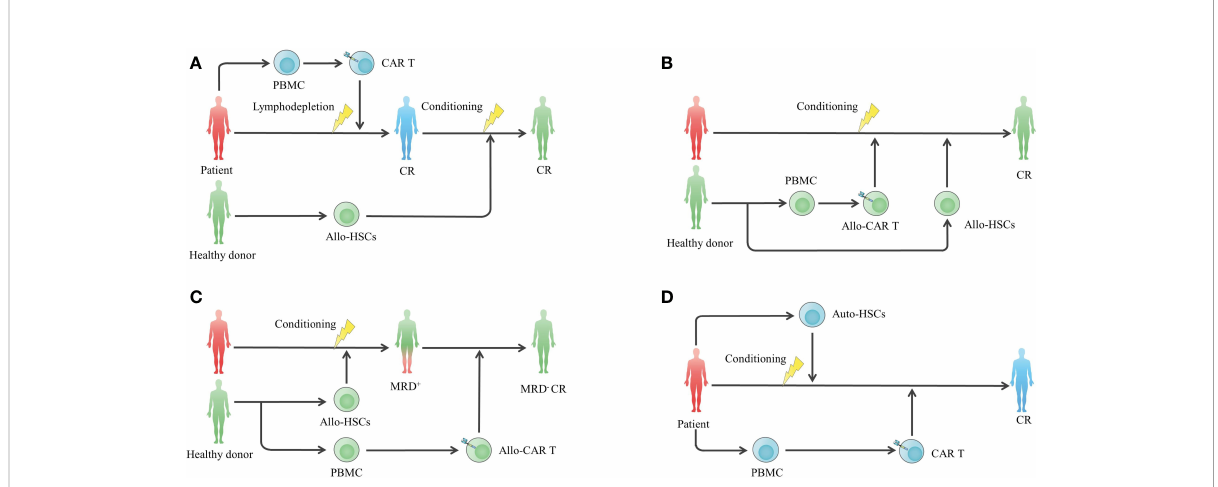
FIGURE 3 HSCT in combination with CAR T cell therapy to enhance ef fi cacy. (A) Standard-of-care CAR T cell therapy following consolidative allo-HSCT. (B) Concurrent infusion of allo-CAR T cells and allo-HSCT to enhance antitumor effects and prolong the persistence of allo-CAR T cells without additional gene editing against graft rejection. (C) Allo-HSCT following allo-CAR T cell therapy for MRD clearance. (D) High-dose chemotherapy conditioning and autologous stem cell transplantation to remodel the immune environment for subsequent CAR T cell therapy. allo-HSC, allogeneic haemopoietic stem